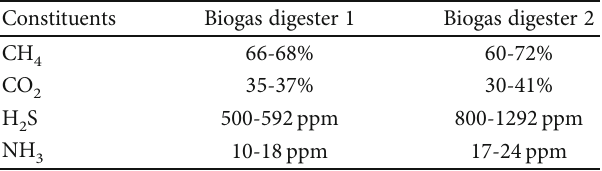
Figure 1: Schematic diagram of the adsorption experiment. Table 1: Composition of biogas.